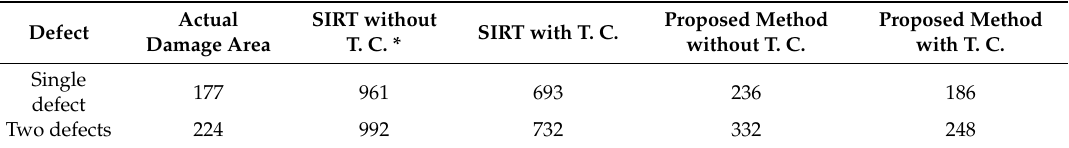
Table 1. Number of grids that are covered by the damage area compared to the numbers that are calculated by the SIRT and proposed methods. SIRT without SIRT with T. C. T. C. *